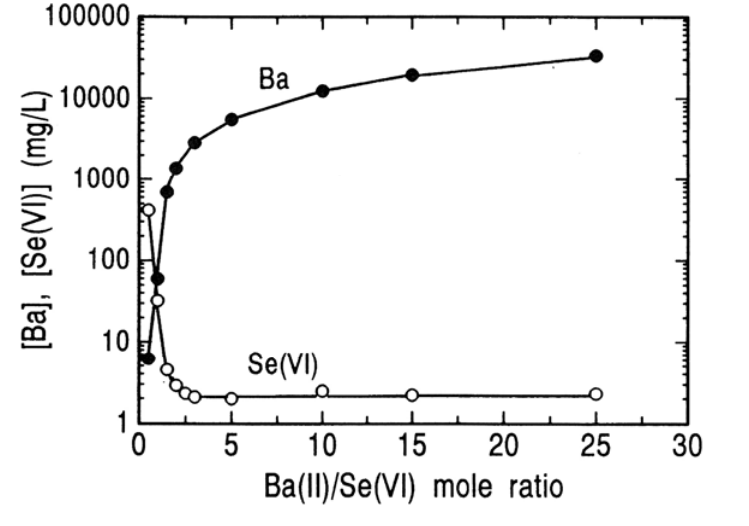
Figure 12. Residual concentrations of barium and selenium(VI) after precipitation of at different mole ratio of Ba(II)/Se(VI) in the starting solution. [Se(VI)] BaSO 4 pH = 6; 25 °C; 24 hours.